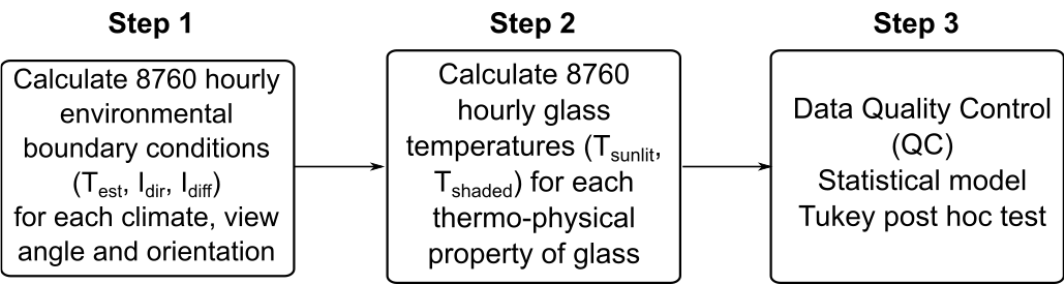
Figure 2. Three-step process for the calculation of the temperature gradient in glasses. Table 4. View angles ( ◦ ) and orientations analyzed for each location.